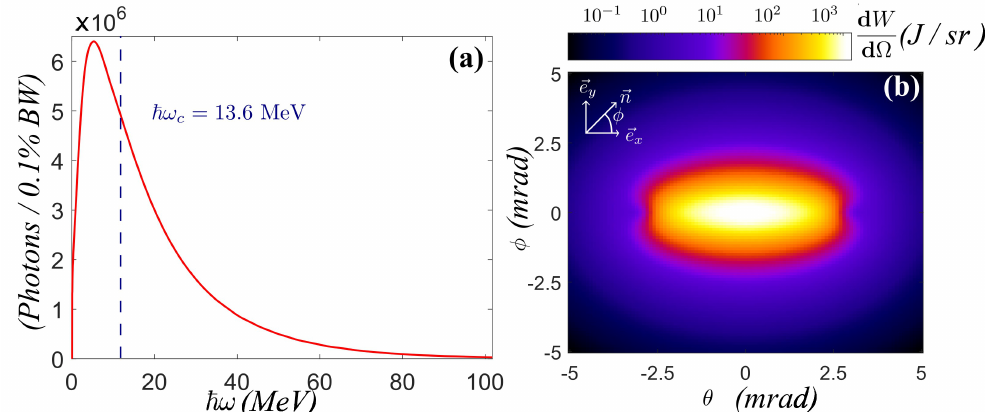
Figure 4. ( a ) The spectral distribution of photons per 0.1% bandwidth; ( b ) angular distribution of radiated energy in the ICS scheme.